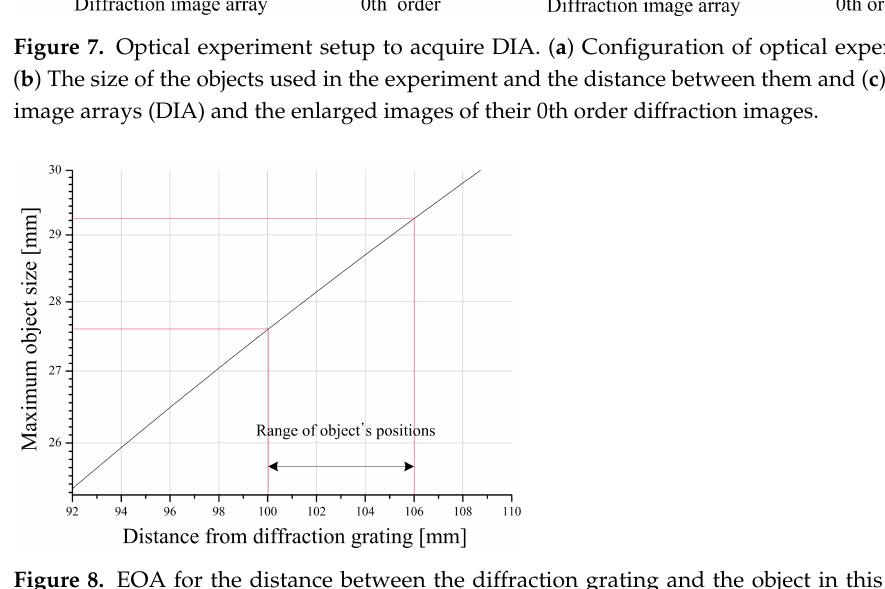
Figure 8. EOA for the distance between the diffraction grating and the object in this diffraction grating imaging